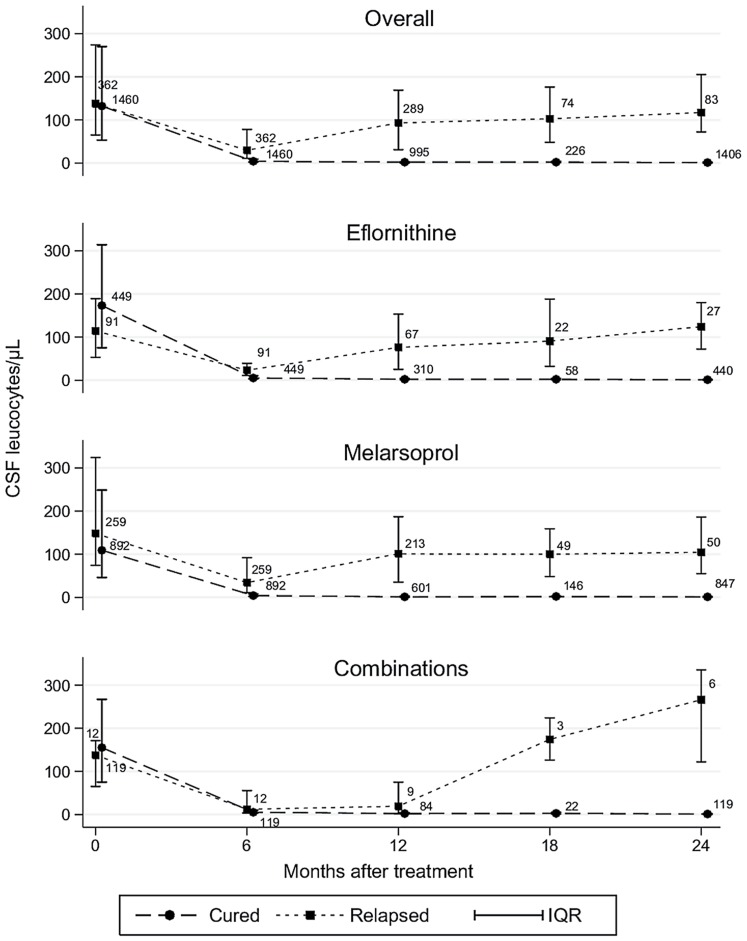
Evolution of the CSF leucocytes count by final treatment outcome, by treatment group and overall.CSF leucocytes count expressed as the median and interquartile range (IQR). Cohort of 1822 patients having a leukocytes count performed at 6 months and not relapsing at 6 months or earlier, who had a complete follow-up. Values at month 0 are pre-treatment measurements. The number of patients per group is shown at each time point. Dotted lines are used to signify that samples over time contain some different patients.